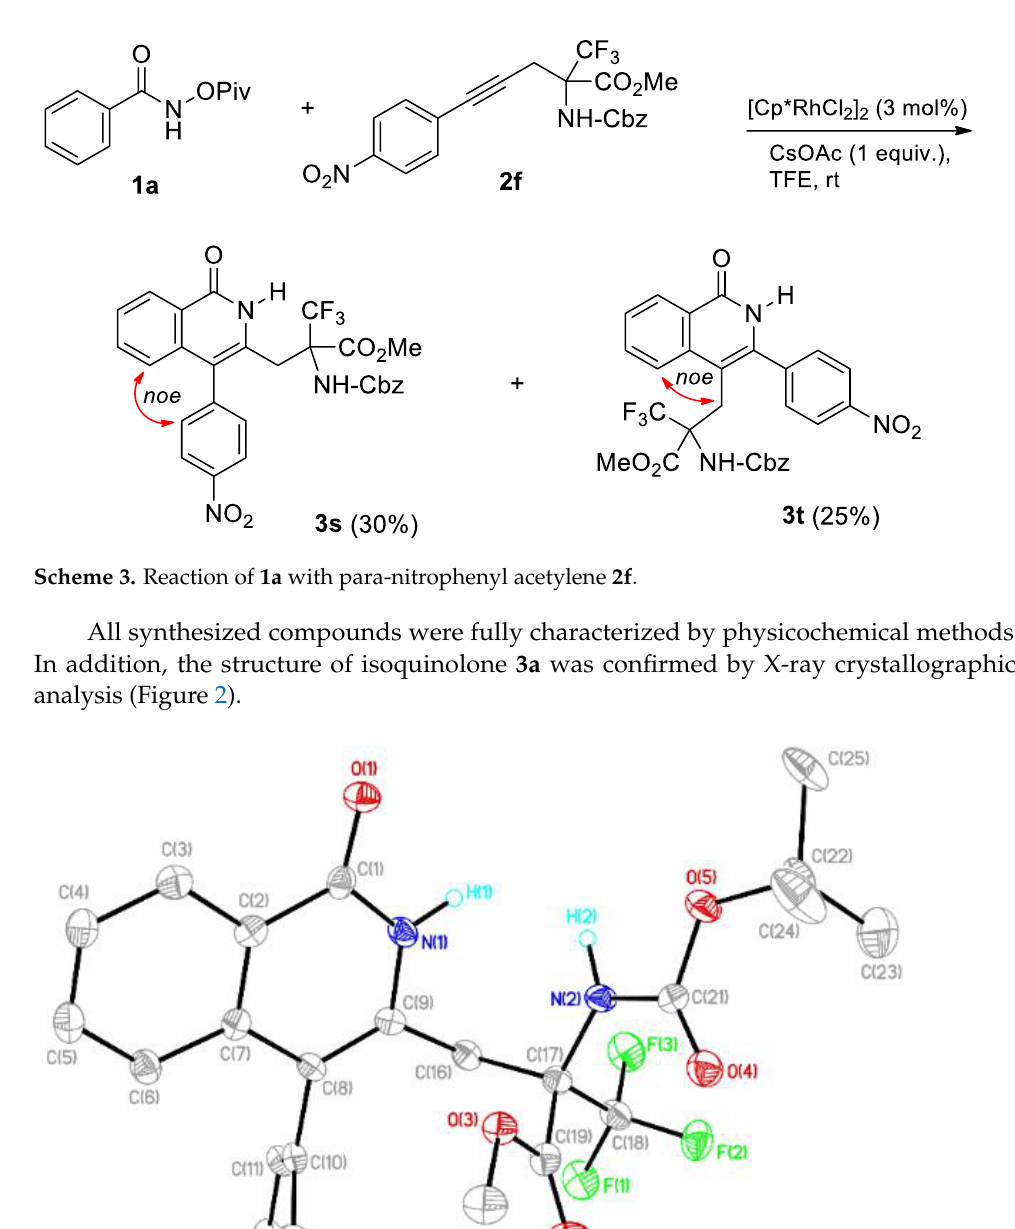
Figure 2. ORTEP representation of the molecular structure of 3a (CCDC 2217085). Thermal ellipsoids are drawn at the 30% probability level).